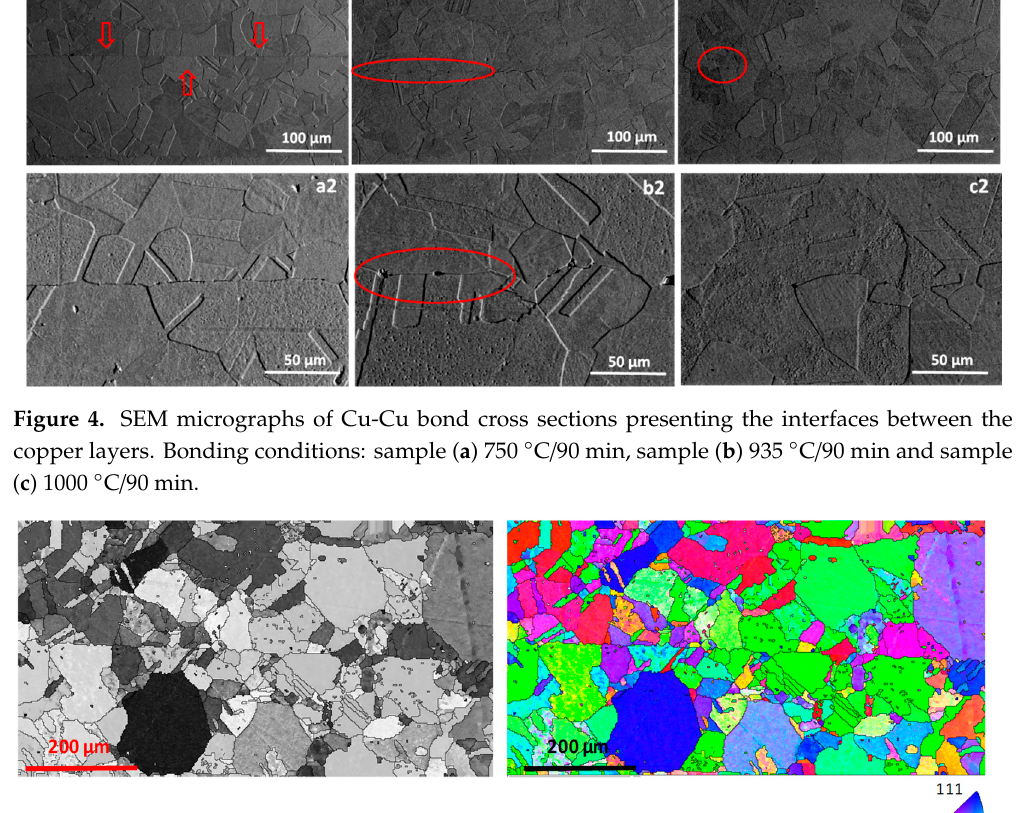
Figure 5. EBSD Band Contrast (left) and Inverse Pole Figure (IPF) (right) maps in the bonding zone. Bonding conditions of specimen: 1000 °C/90 min.